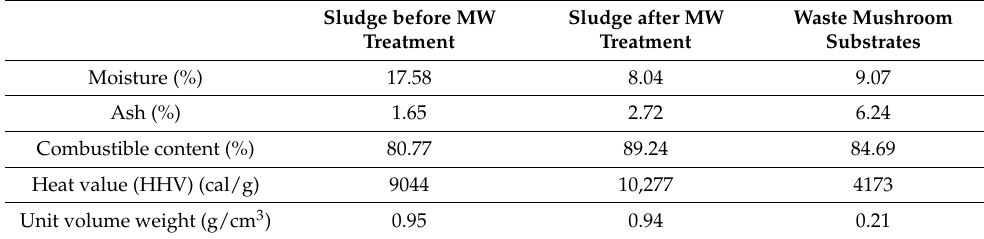
Table 1. Substance analysis of oily sludge and waste mushroom substrates.